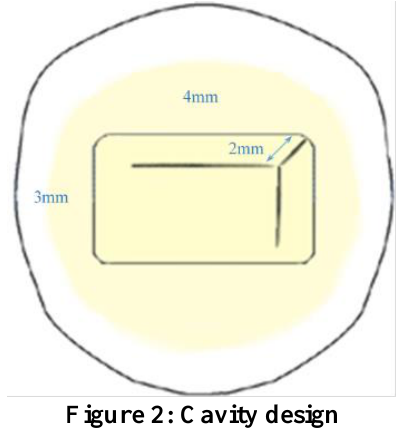
Figure 2: Cavity